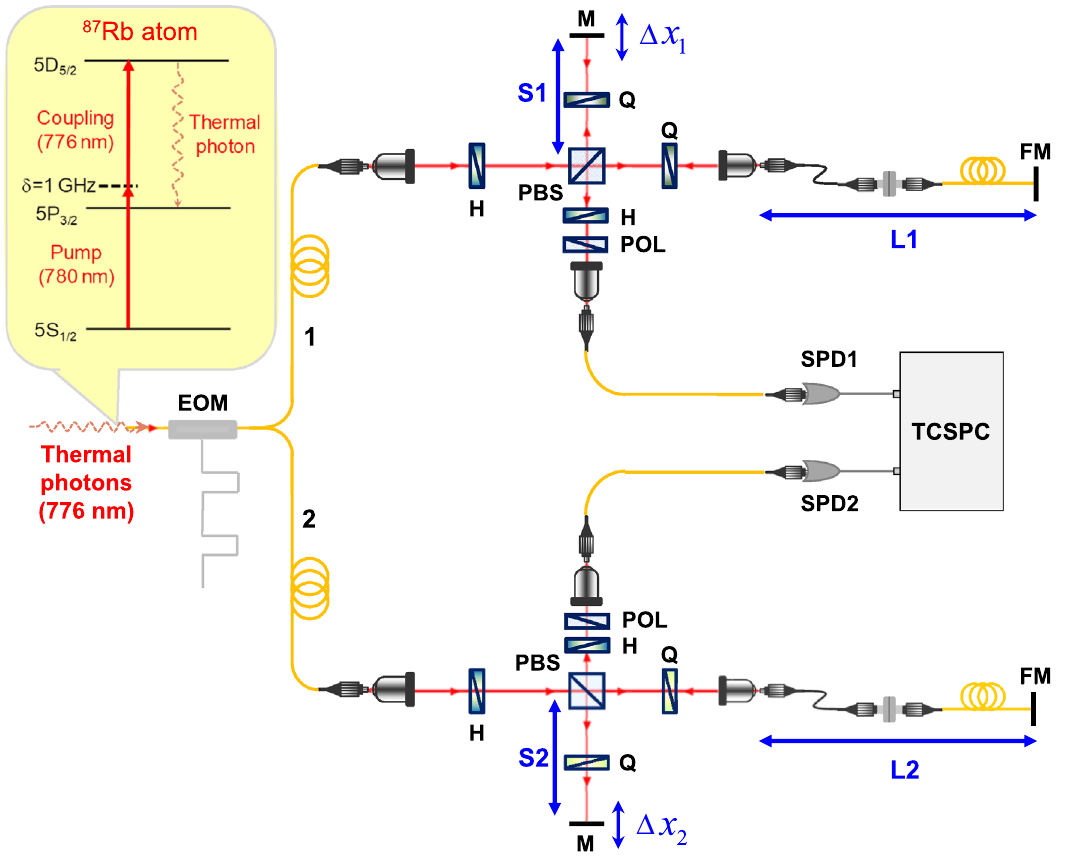
Figure 2. Experimental setup for Franson-type interference with thermal light. SOI obtained using unbalanced Michelson interferometers with large path difference (EOM: electro-optic modulator; H: half-wave plate; Q: quarter-wave plate; M: mirror; POL: polarizer; PBS: polarizing beam splitter; FM: fiber mirror; SPD: single- photon detector; TCSPC: time-correlated single-photon counting module). Numerically calculated phase- matching function values as a function of the propagating angle ( θ ) of the generated FWM for various tilt angles ( θ d ) of the driving laser in the four-wave mixing process using a Doppler-broadened cascade-type atomic